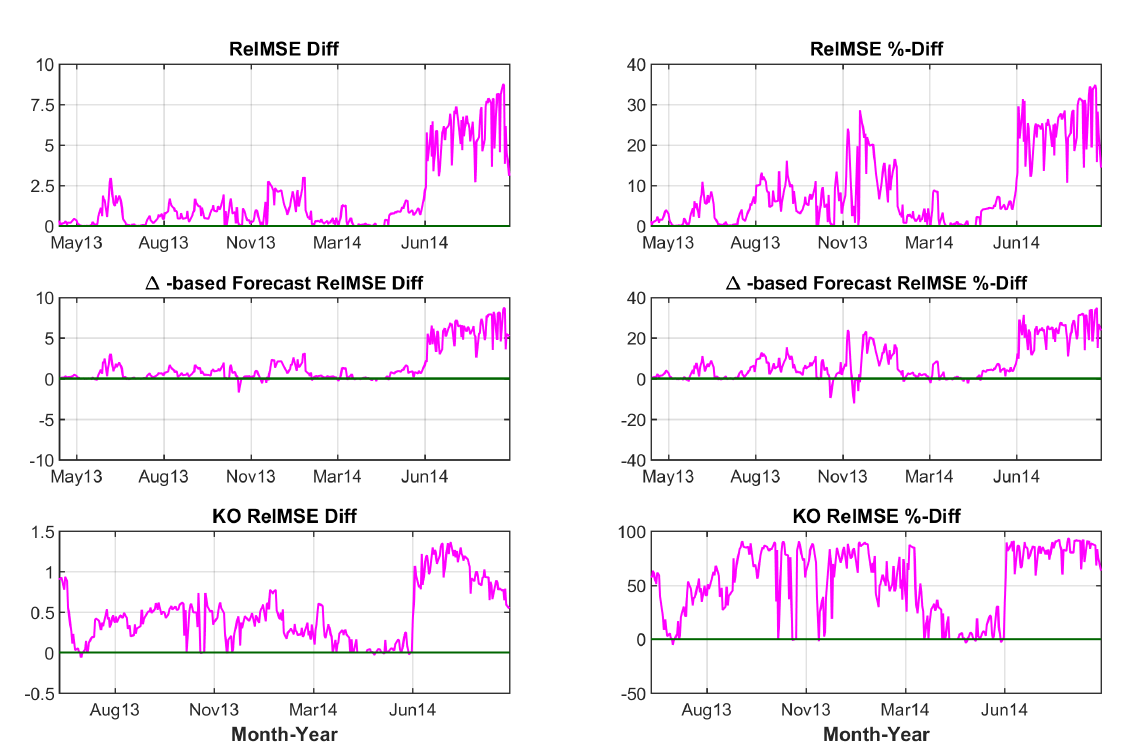
Figure 7. Quanto calls and KO options. Top: RelMSE-difference for the calibration. Middle: RelMSE-difference of the delta-based forecasts. Both sample period 16 April 2013 to 15 September 2014. Bottom: RelMSE-difference using the respective calibrated parameters from 19 June 2013 to 15 September 2014. Calculations were based on 20,000 sample paths simulated on each considered trading day assuming 5 daily trading hours and sampling every 15 s. Positive values indicate better performance of the NTS